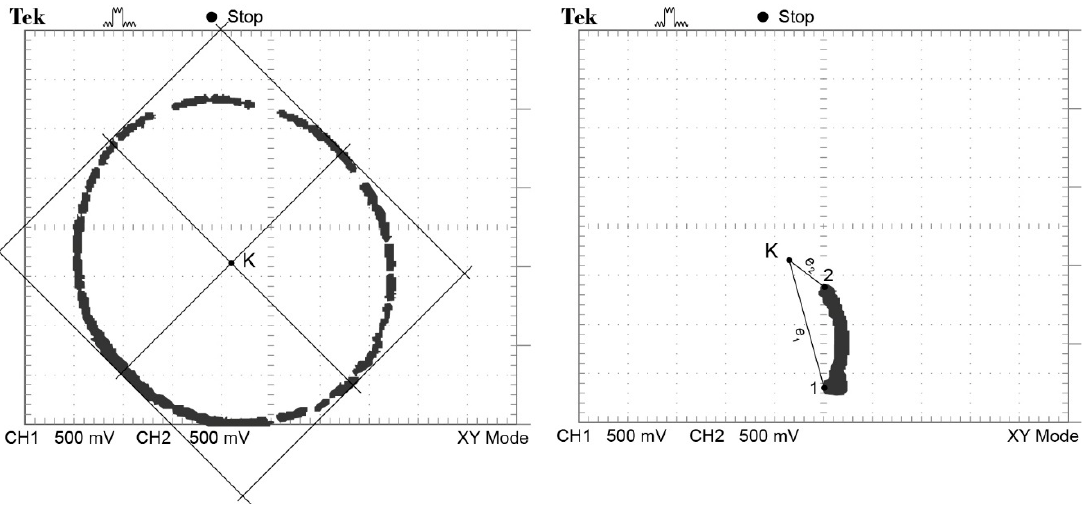
Figure 13. The clearance circle and the trajectory of the journal center at the speed of 2000 rpm and at its change to 260 rpm: K—center of clearance circle, 1—position of journal center for 2000 rpm, 2—position of the journal center for 260 rpm, e 1 —value of eccentricity for point 1, e 2 —value of eccentricity for point 2.